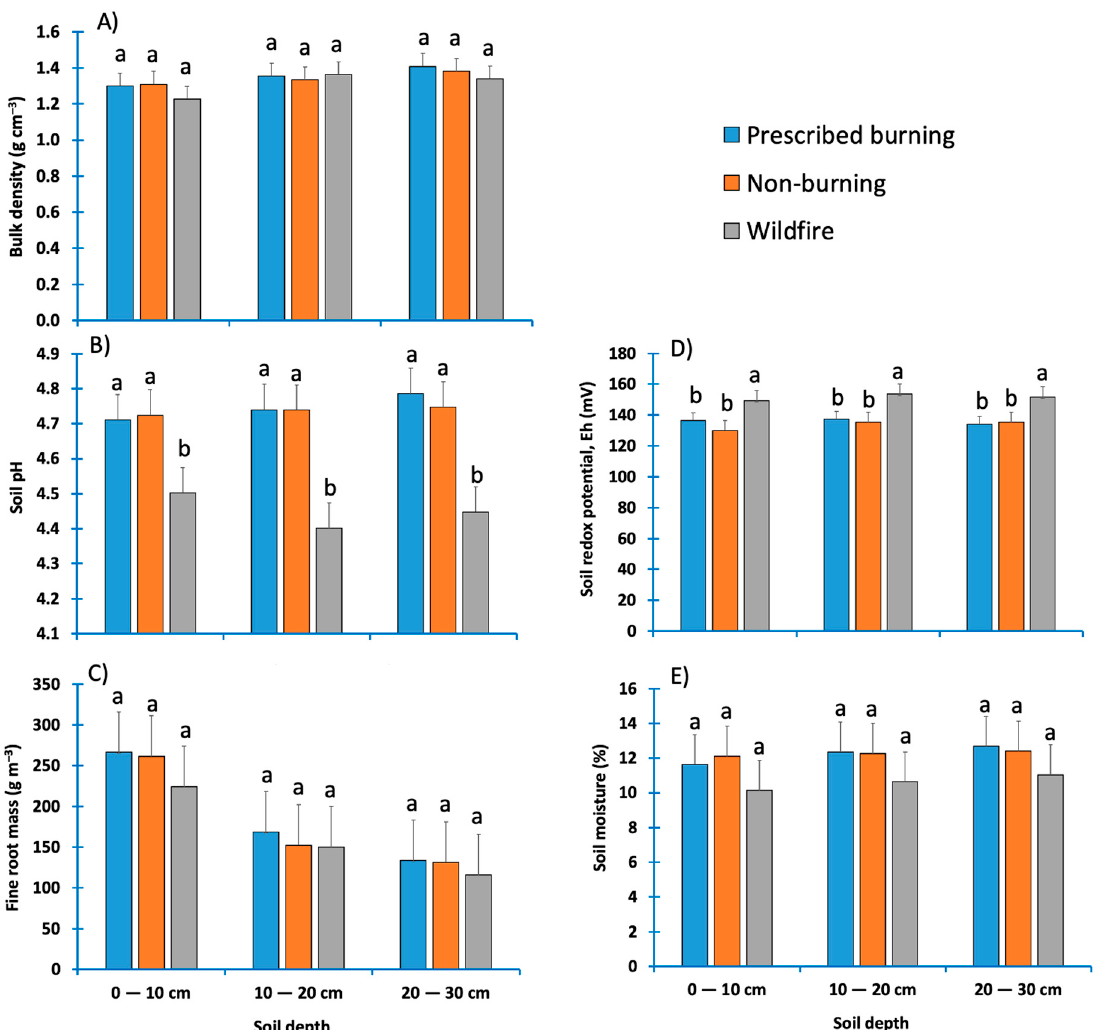
Figure 6. Soil properties and fine root biomass among prescribed burning, non-burning, and wildfire sites at different depth classes. ( A ) Soil bulk density, ( B ) soil pH, ( C ) fine root mass, ( D ) soil redox potential, and ( E ) soil moisture. Error bars indicate respective 95% confidence intervals. Different letters over the bars indicate significant differences between burning types ( p < 0.05) within the same depth class.